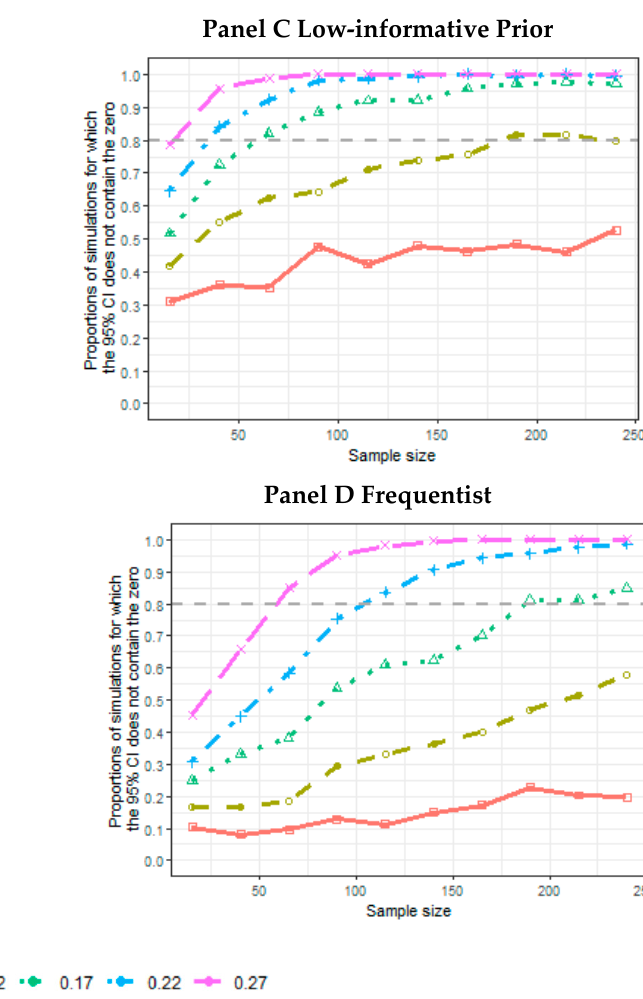
Figure 2. The proportion of CIs within simulated trials not including the zero absolute risk reduction (ARR) according to the sample size, and true ARR for informative prior (Panel A), low-informative prior (Panel B), uninformative prior (Panel C), and frequentist analysis (Panel D).